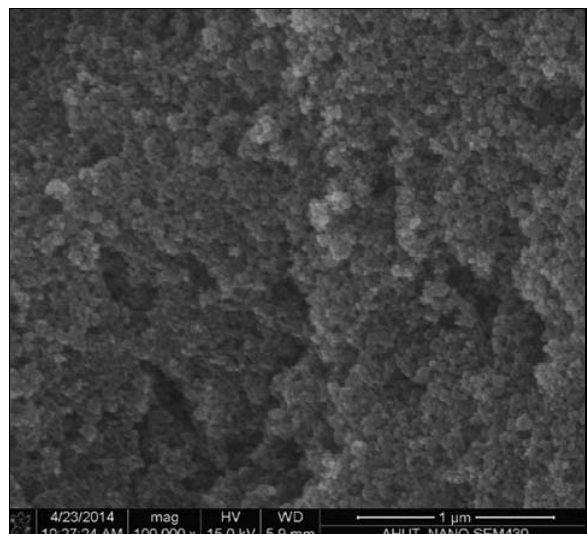
Fig. 1. SEM image of ZnO seeds.